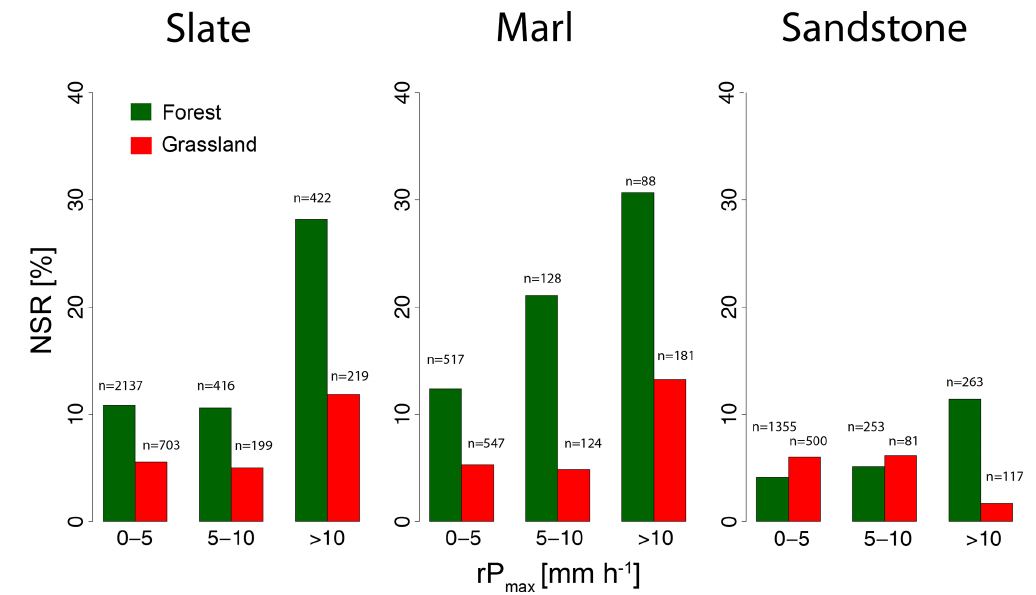
Figure 5. NSR vs. rP max . The numbers above the bars ( n ) indicate the number of events per class.